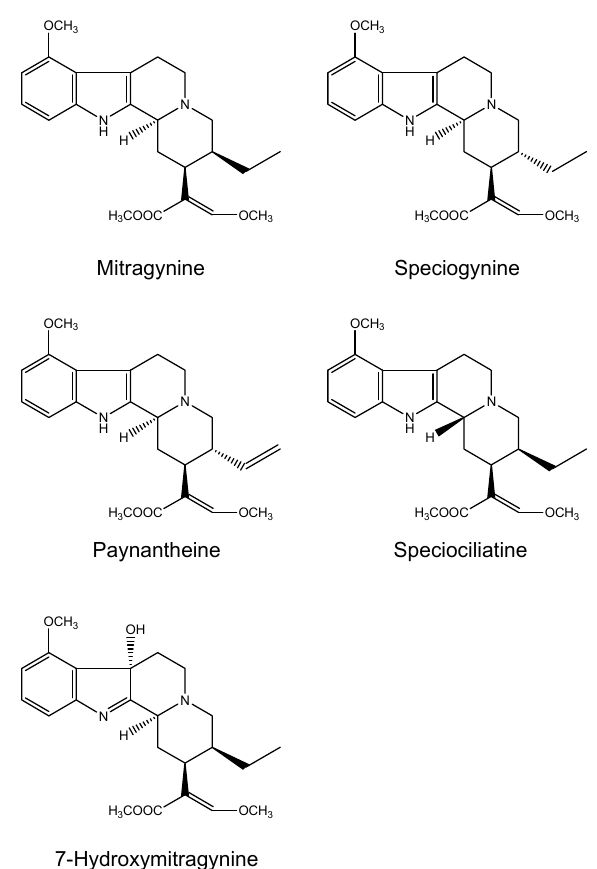
Figure 7. Chemical structures of the most abundant indole alkaloids in M. speciosa .